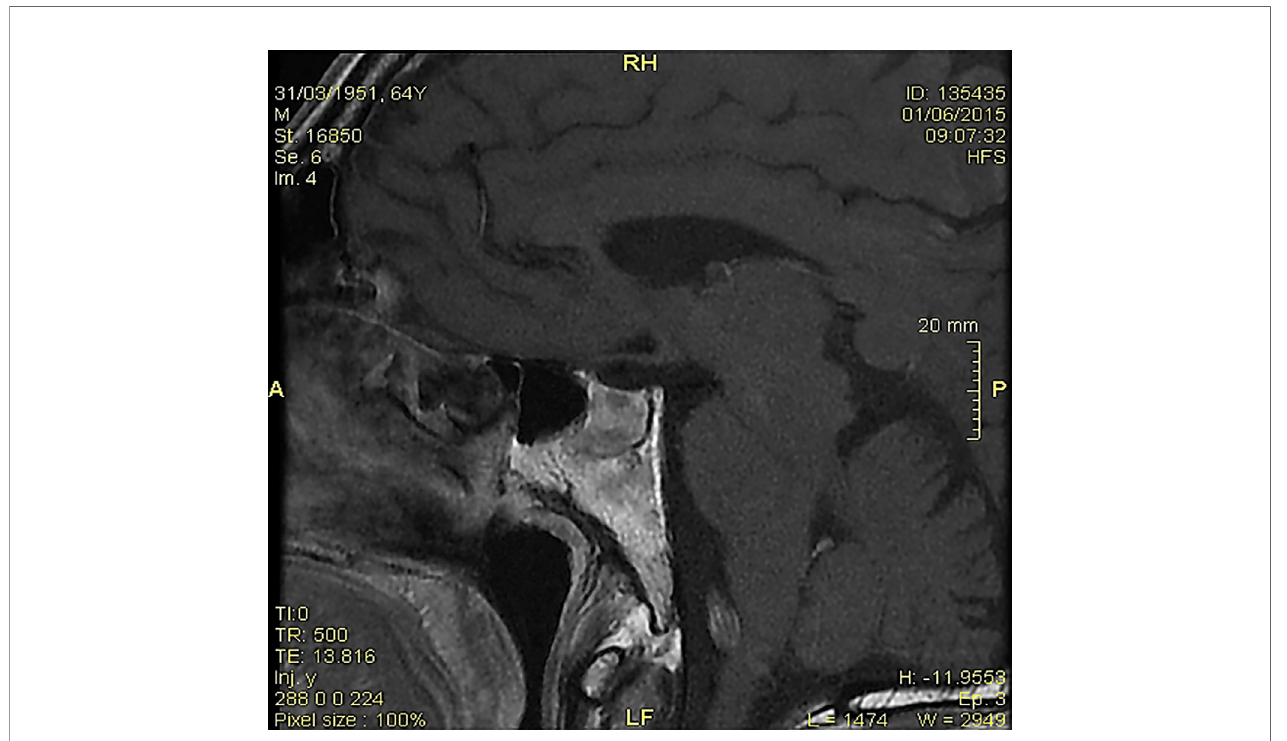
FIGURE 1 | At the magnetic resonance imaging, pituitary microinfarcts in an enlarged gland were shown; the hypophyseal stalk was normal, and the neurohypophyseal ‘ bright signal ’ in T1 sequences was